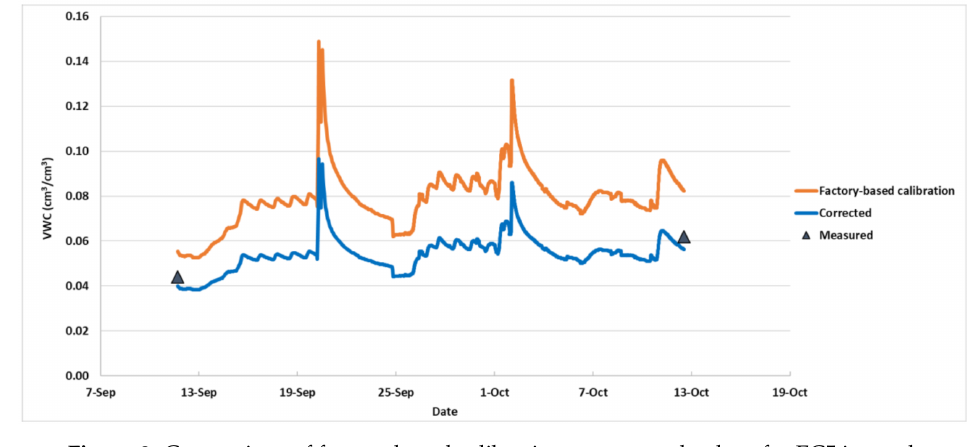
Figure 8. Comparison of factory-based calibration to corrected values for EC5 in sand.